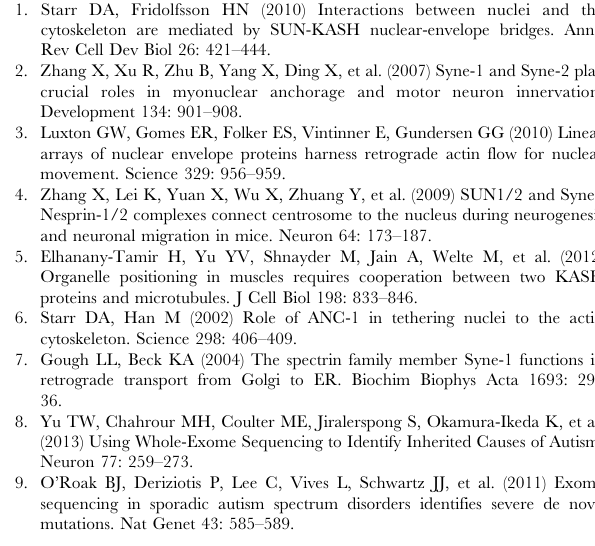
Figure S2 Further examples of ANC-1 coIP with RPM-1. Shown are two independent examples of coIPs from transgenic worm lysates showing that endogenous ANC-1 binds to RPM- 1::GFP. (PDF) Figure S3 anc-1 , bar-1 and the Wnt cwn-2 regulate axon termination in the ALM mechanosensory neurons. ALM axon termination defects were quantitated for the indicated genotypes using muIs32 [P mec7 GFP]. (A) anc-1 mutant analysis (B) bar-1 mutant analysis. (C) cwn-2 mutant analysis. Note that zdIs5 (P mec- 4 GFP) was used for cwn-2 analysis because both muIs32 and cwn-2 are on chromosome II. Analysis was done on young adults grown at 23 u C. Significance was determined using an unpaired Student’s t test; error bars represent the standard error of the mean. * P , 0.05, (TIF) Figure S4 RPM-1::GFP localizes at low levels in neuronal cell bodies, but is excluded from the nucleus. Epifluorescent microscopy was used to visualize transgenic animals, juIs58 , in which RPM-1::GFP was expressed using the native rpm-1 promoter. In the ventral cord motor neurons, RPM-1::GFP was concentrated at the presynaptic terminals (arrowheads). RPM- 1::GFP was also localized at low levels in the cell bodies of motor neurons, where it was excluded from the nucleus (arrows).